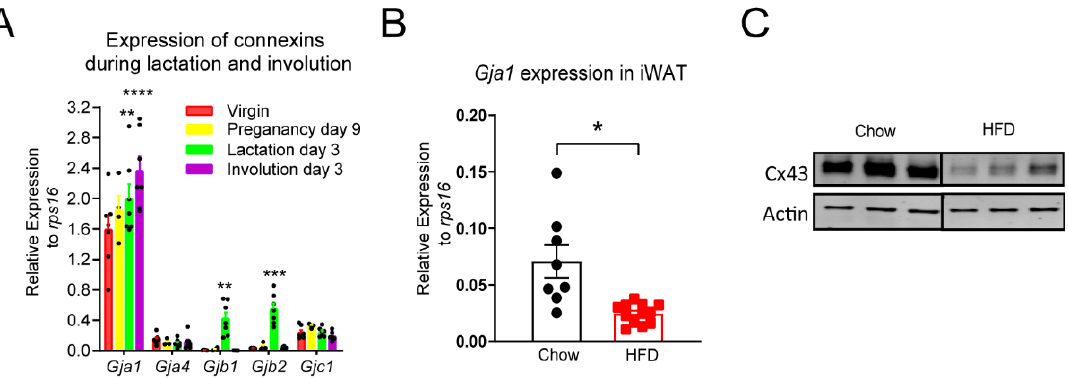
Figure 2. Mammary adipose tissue connexin expression at different stages of pregnancy/lactation and the effect of HFD feeding on mammary adipose tissue’s major connexin isoform Gja1 expression. ( A ) Expression of Gja1 , Gja4 , Gjb1 , Gjb2 , and Gjc1 in mammary fat pads from virgin mice, mice 9 days after successful mating (Pregnancy Day 9), mice 3 days post-parturition and lactating pups (Lactation Day 3), or mice 3 days post-weaning without a second round of pregnancy (Involution Day 3) ( n = 7 mice). ** p < 0.01, *** p < 0.001, **** p < 0.0001, comparing to virgin group. ( B ) Expression of Gja1 in inguinal white adipose tissue (iWAT) from mice fed with HFD for 12 weeks was reduced. ( n = 8 for chow, n = 12 for HFD). * p < 0.05. ( C ) Western blots showing a reduction in Cx43 protein abundance in inguinal mammary adipose tissue from mice fed with HFD for 12 weeks. All data are mean ± SEM. The original bolt can be found in Supplementary Figure